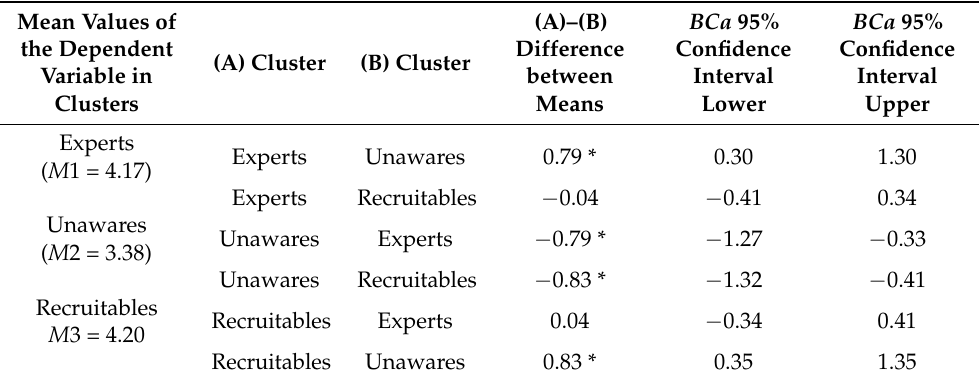
Table 3. Results of the Bonferroni post-hoc comparisons after performing a one-way ANOVA for the dependent variable: “The credible maximum effect of omitted hand hygiene is without